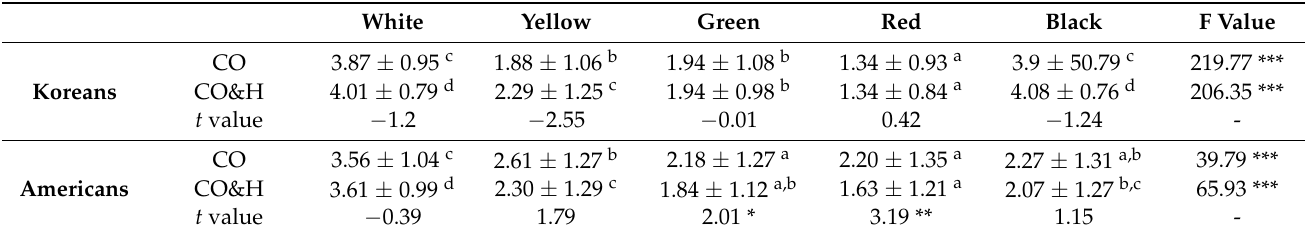
Table 5. Familiarity according to the colors and health functionality information of colored rice in the Korean and American groups. White Yellow